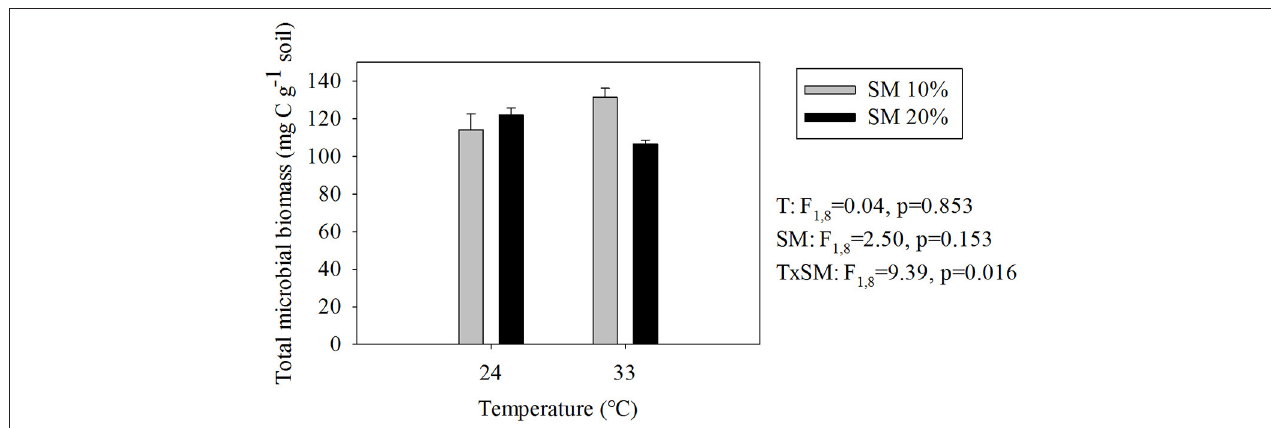
FIGURE 3 | Estimated total microbial biomass (means ± SE; n = 12) at different temperature and soil moisture conditions. SM, Soil moisture.